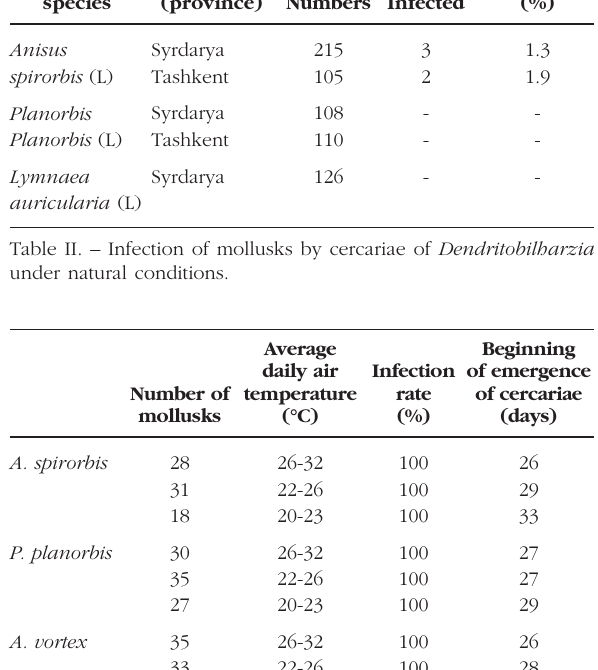
Table III. – Effect of temperatures on time of emission of cercariae D. loossi from mollusks.